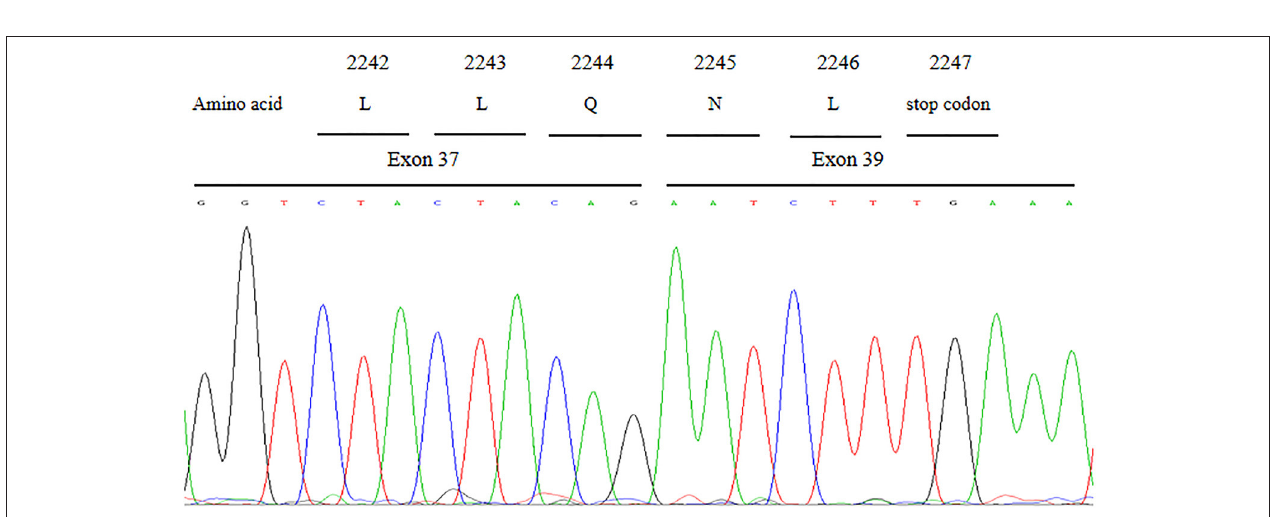
FIGURE 4 | Partial cDNA sequence chromatograms of VPS13B . The aberrant splicing resulted in the skipping of entire exon 38 and abnormal direct joining of exon 37 and exon 39, which further gave rise to the generation of a premature in-frame stop codon at code 2,247.